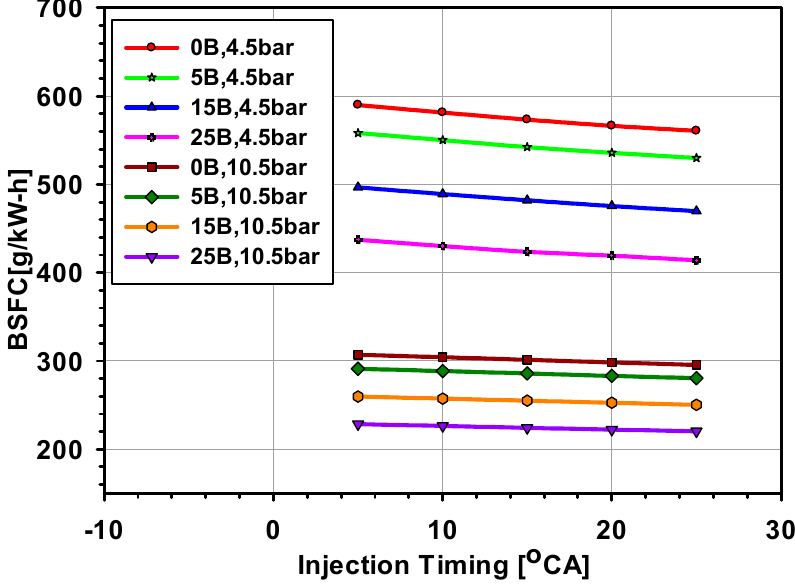
Figure 15. Variation of BSFC with injection timing.